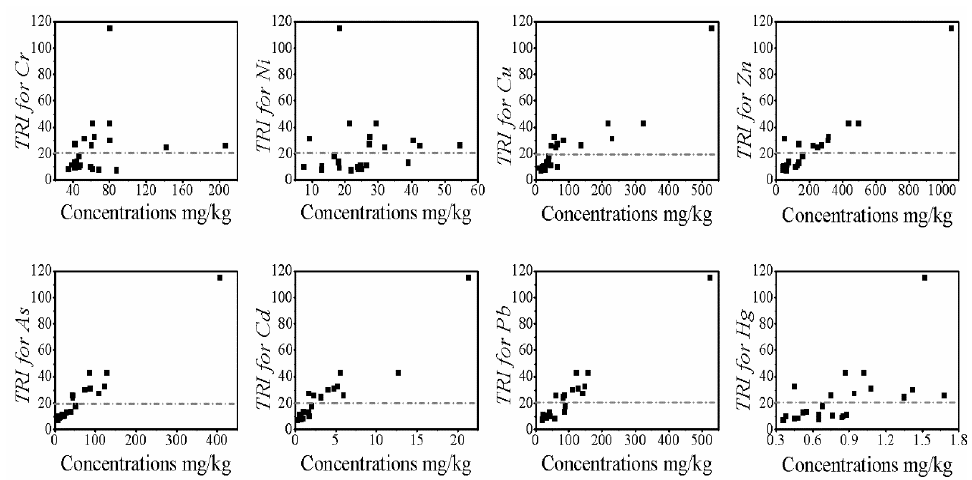
Figure 5. The TRI values of Cr, Ni, Cu, Zn, As, Cd, Pb, and Hg in sediments based on SQG values (TEL, PEL) and total heavy metal concentrations.